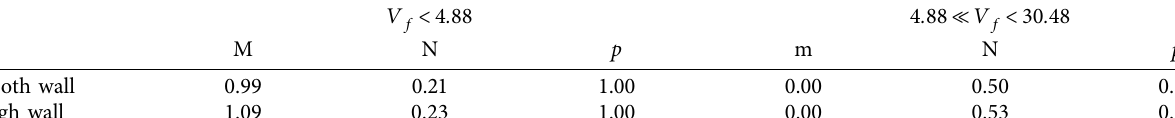
Table 4: Coefficients of the McAdams correlation according to the nature of the wall [40].